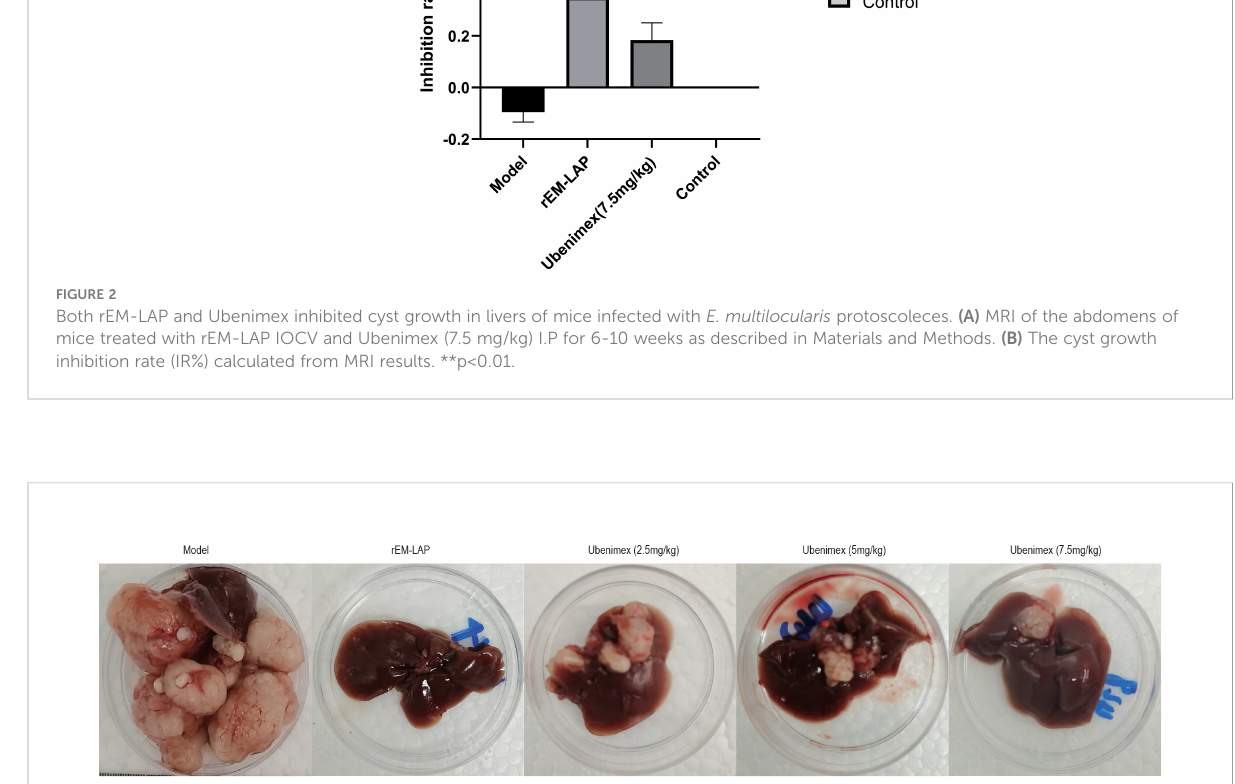
FIGURE 3 Both rEM-LAP and Ubenimex inhibited cyst growth in the livers of mice infected with E. multilocularis protoscoleces in the late AE stage. Lives excised at week 17 from mice treated with PBS; rEM-LAP; 2.5 mg/kg Ubenimex; 5 mg/kg Ubenimex; and 7.5 mg/kg Ubenimex.